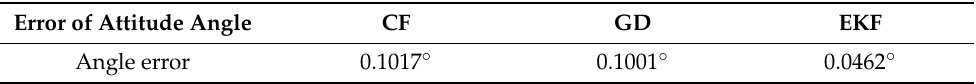
Table 7. Static attitude angle error after three kinds of filtering are